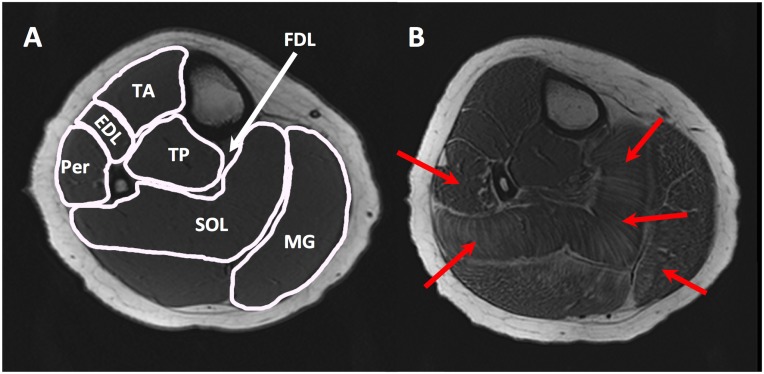
T1 weighted images of lower leg muscles.Representative T1 weighted 3-D gradient echo images of A) control, and B) DMD subject. Outline of regions of interest (A) showing different muscles namely TA, tibialis anterior; EDL, extensor digitorum longus; Per, peroneal; MG, medial gastrocnemius; SOL, soleus; TP, tibilais posterior; FDL, flexor digitorum longus. (B) Showing areas of fatty tissue infiltration in leg muscles.